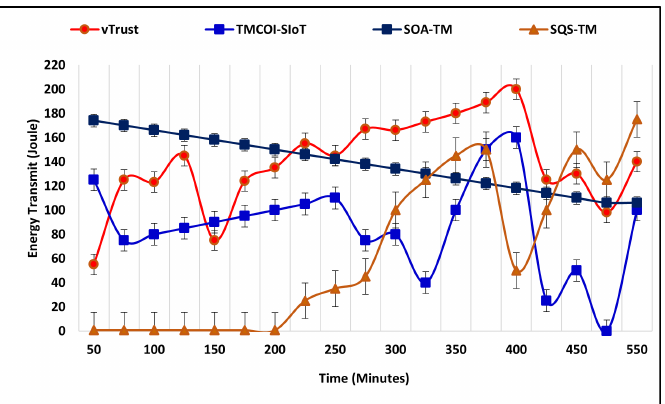
Figure 8. Average energy shared in urban